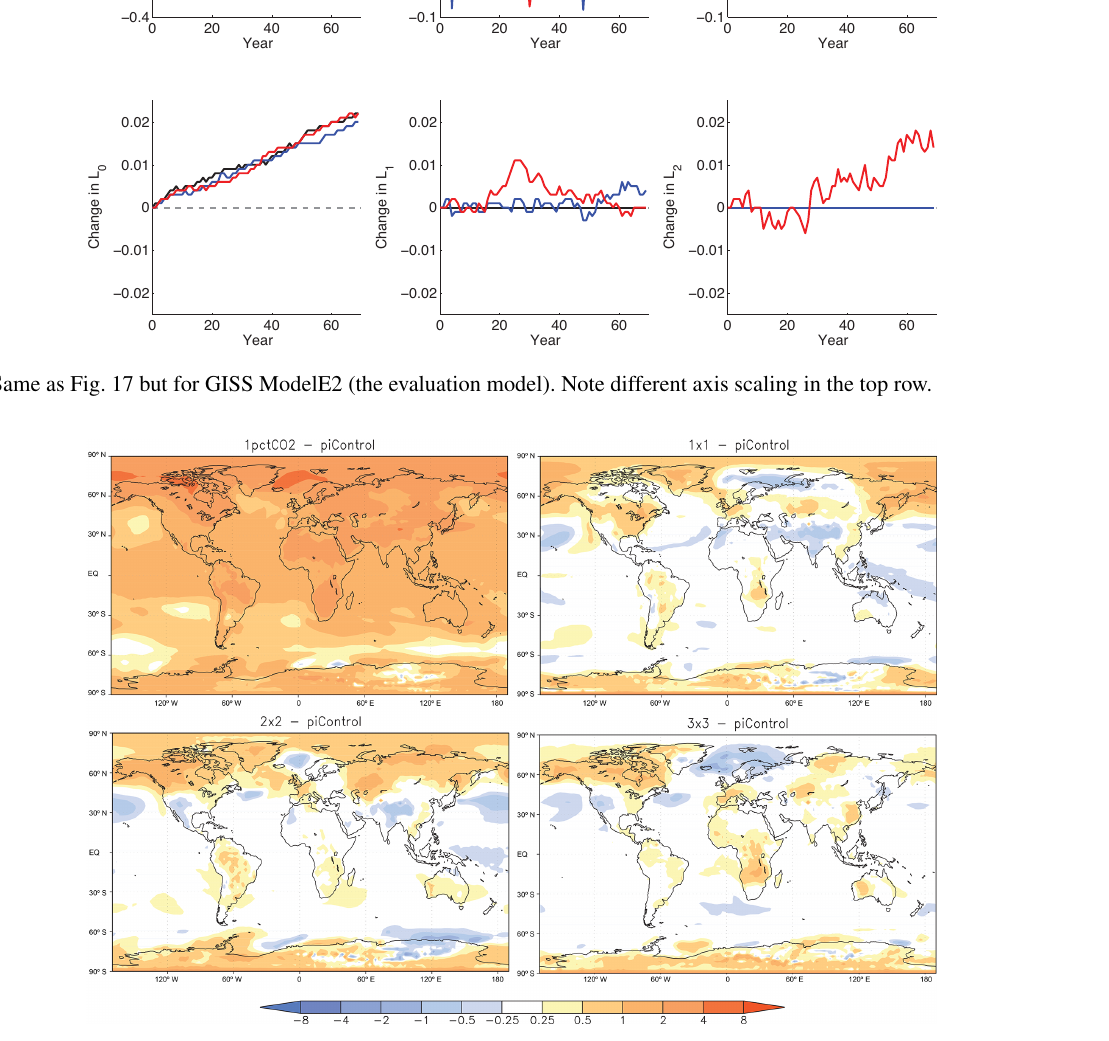
Figure 22. Same as Fig. 19 but for GISS ModelE2 (the evaluation